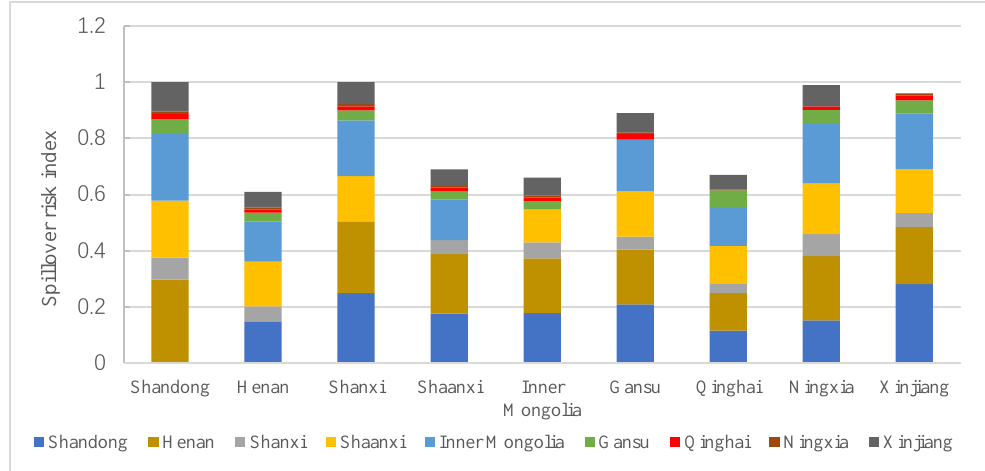
Figure 6. Spillover risk index of interprovincial virtual water trade within the Yellow River Economic Belt. (Source: Authors’ own calculation / conception, based on MATLAB software)